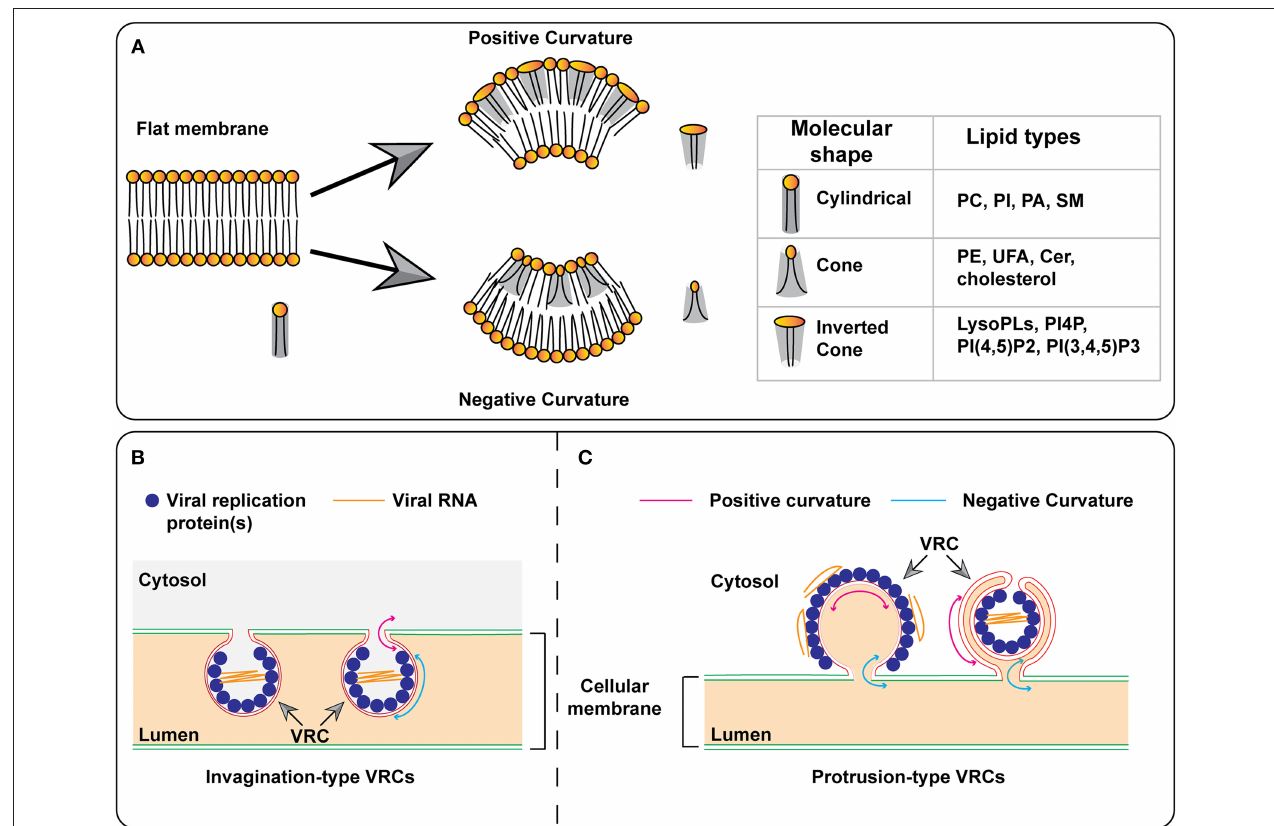
FIGURE 4 | Models for the formation of membrane curvature and viral replication complexes. (A) The insertion of certain lipids with cone or inverted-cone shape generates negative or positive membrane curvature, respectively. (B,C) Models for the formation of invagination- and protrusion-type replication complexes. In the protrusion-type model, the VRC on the right represents the double-membrane vesicle (DMV). PC, phosphatidylcholine; PI, phosphatidylinositol; PI4P, phosphatidylinositol-4-phosphate; PI(4,5)P 2 , phosphatidylinositol-4,5-bisphosphate; PI(3,4,5)P 3 , phosphatidylinositol-3,4,5-trisphosphate; PA, phosphatidic acid; SM, sphingomyelin; PE, phosphatidylethanolamine; UFA, unsaturated fatty acid; Cer, ceramide; VRC, virus replication